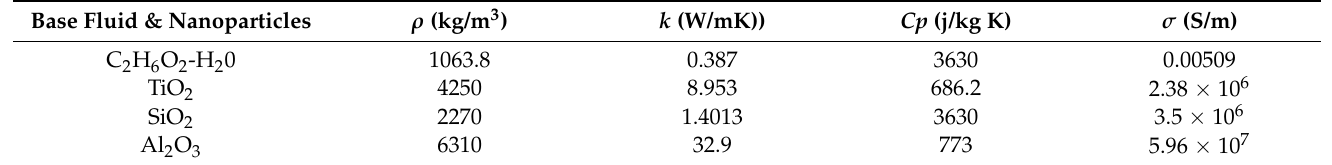
(cid:1) , titanium dioxide 2